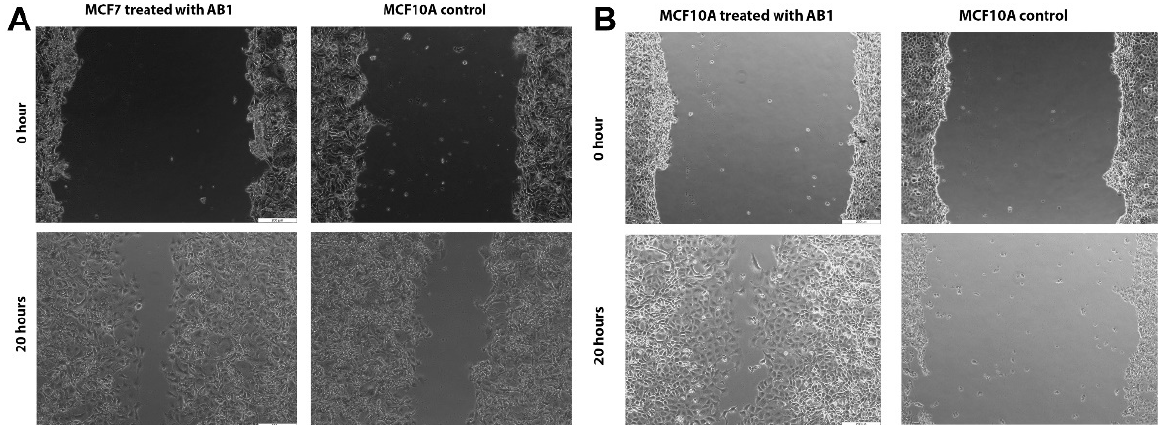
Figure 7. Microscopic images of the effects of aflatoxin B1 on cell migration of MCF7 ( A ) and MCF10A ( B ) cells. The images were obtained at 200 µm scale magnification.